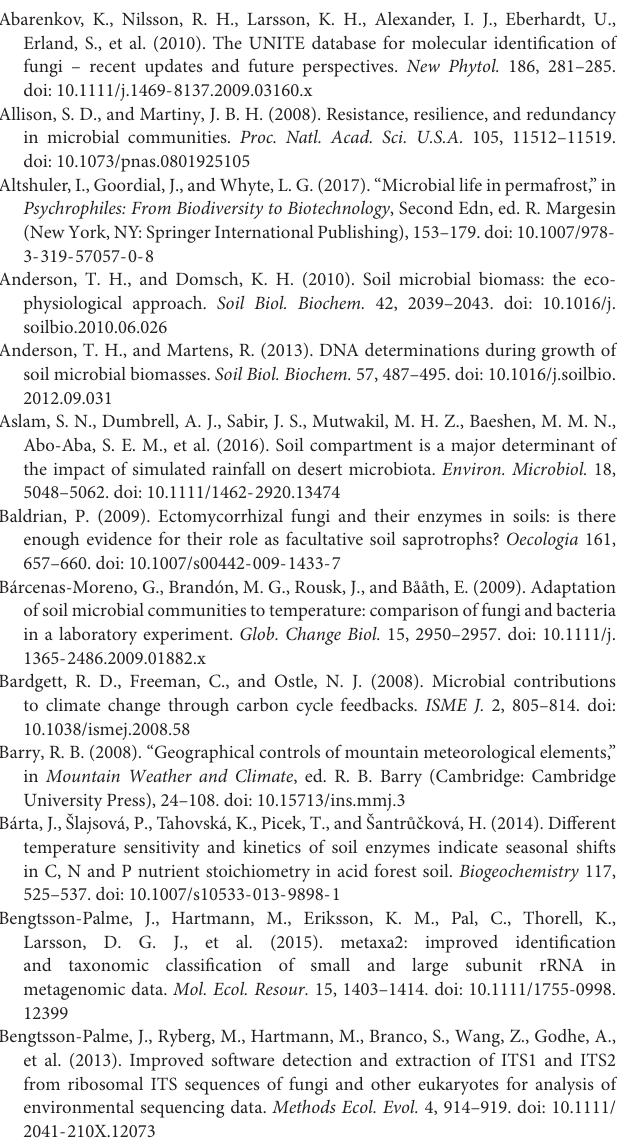
FIGURE S2 | Relationship between microbial community structure and functional parameters (C utilization patterns and potential enzyme activity) displayed by the R 2 values of linear regressions run separately for bacteria and fungi. Vertical lines represent bootstrapped 95% confidence intervals and asterisks represent the significance of the regressions ( ∗ significant; NS, not significant).